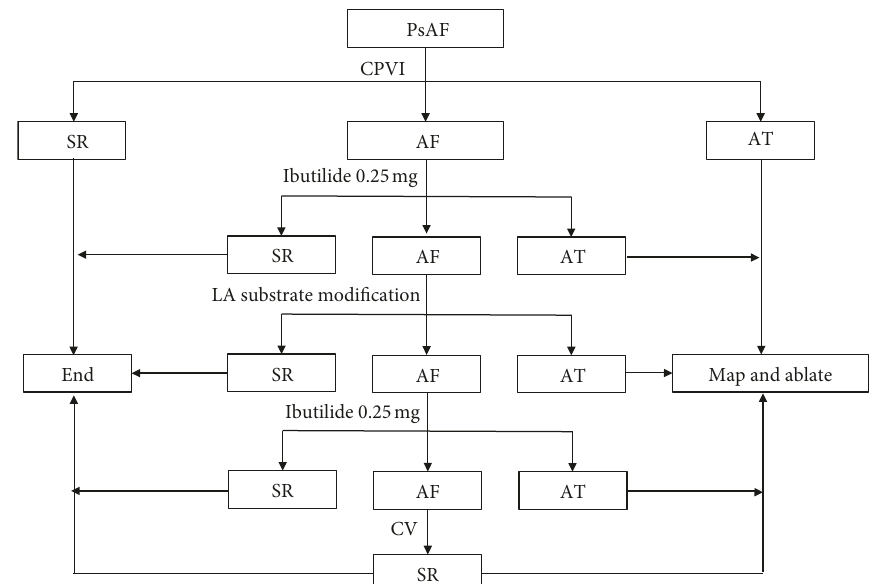
Figure 1: The ablation protocol used in this study. PsAF � persistent atrial fibrillation; SR � sinus rhythm; AT � atrial tachycardia; LA � left atrial; CV �